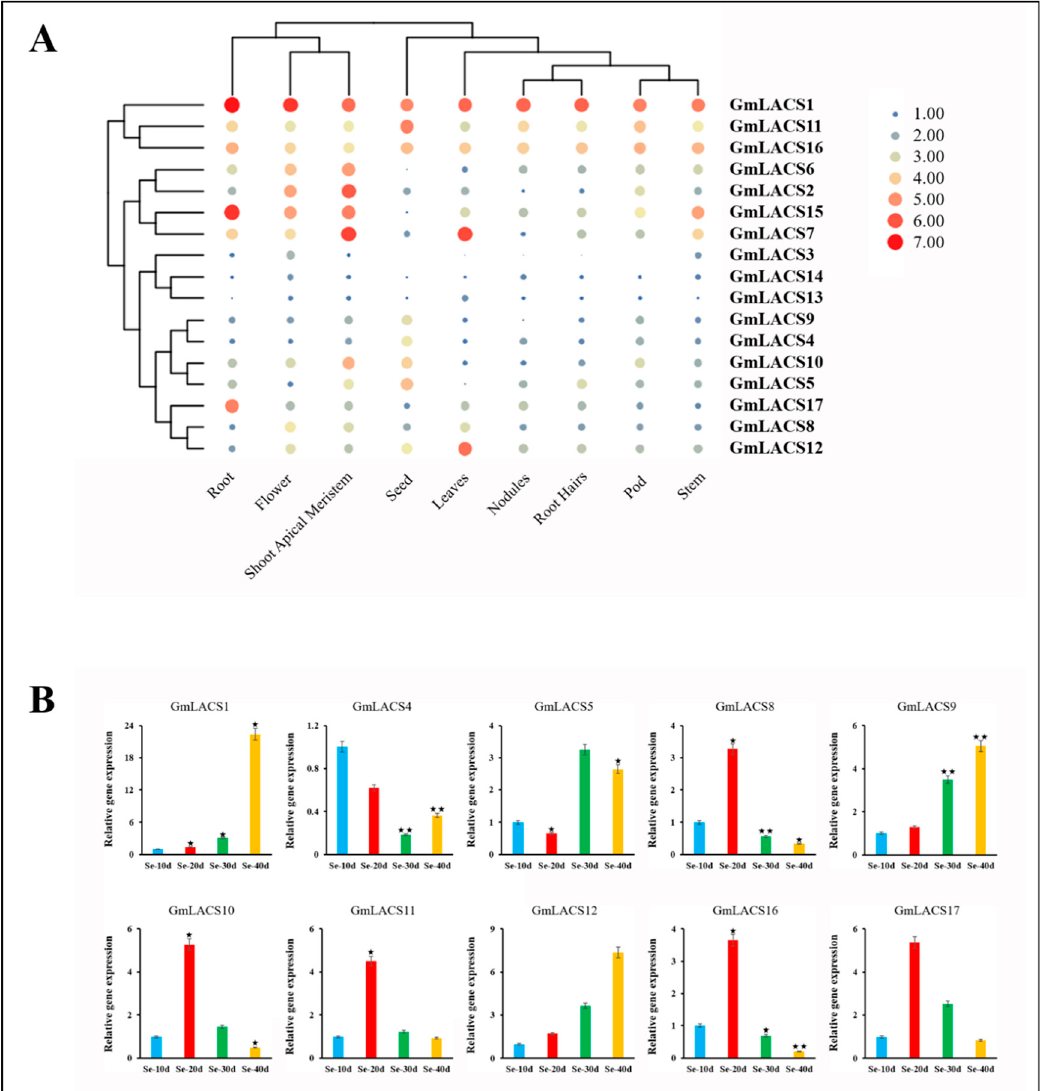
Figure 5. Expression profiles of GmLACSs in multiple tissues and developmental stages. ( A ) Ex- pression patterns cluster analysis of GmLACSs involved in tissue development. The transcripts of GmLACSs genes in various tissues are investigated from Phytozome database. The results are shown as heat maps. The color scale represents log2 expression values, with red denoting high-level transcrip- tion and blue denoting low-level transcription. The size of the circle also indicates the transcription level, with a larger circle indicating high-abundance transcripts. ( B ) Transcriptome analysis was performed at 10, 20, 30 and 40 d (DAF) of soybean seed germination. The transcripts of GmLACSs at four DAFs were studied. Three biological replicates for each tissue were collected. Asterisks above bars denote a statistically significant difference by Student’s t -test (* p < 0.05, ** p <